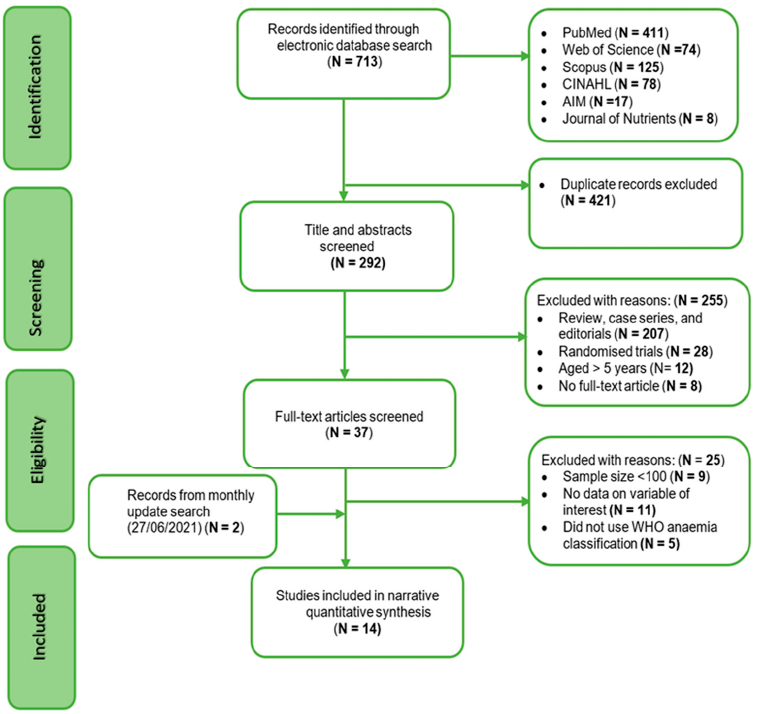
Figure 1. Flow diagram showing selection of studies for inclusion in the systematic review.